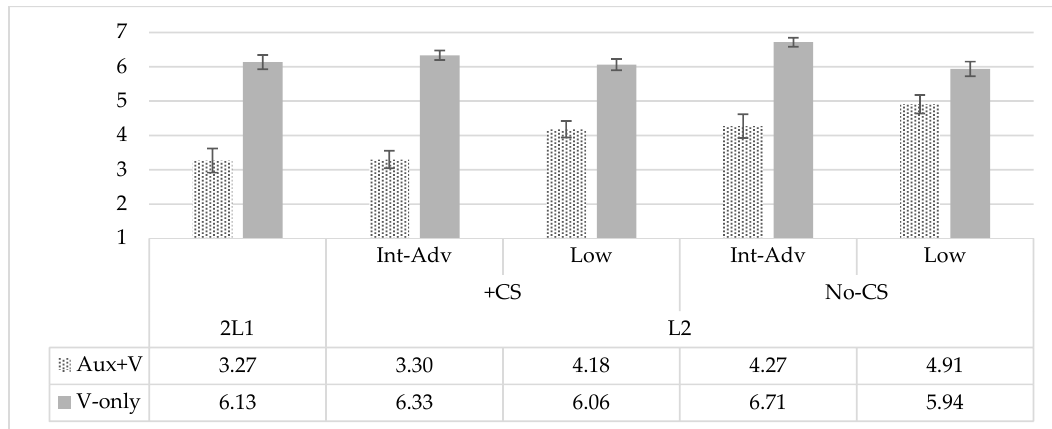
Figure 4. Code-switched English-to-Spanish verb stimuli ratings by group and type. Languages 2018 , 3 , 26